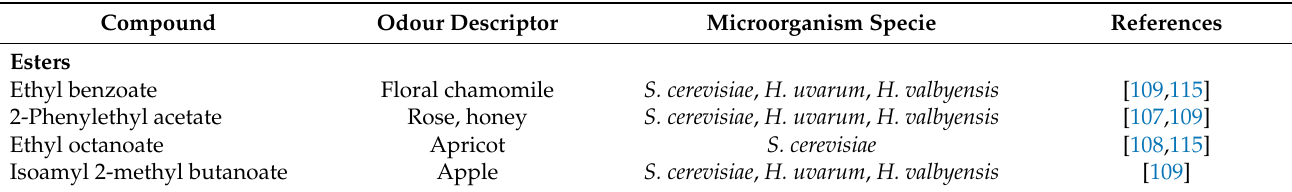
Table 3. Volatile compounds, the corresponded odour descriptors and the microorganisms involved in the fermentation of apple